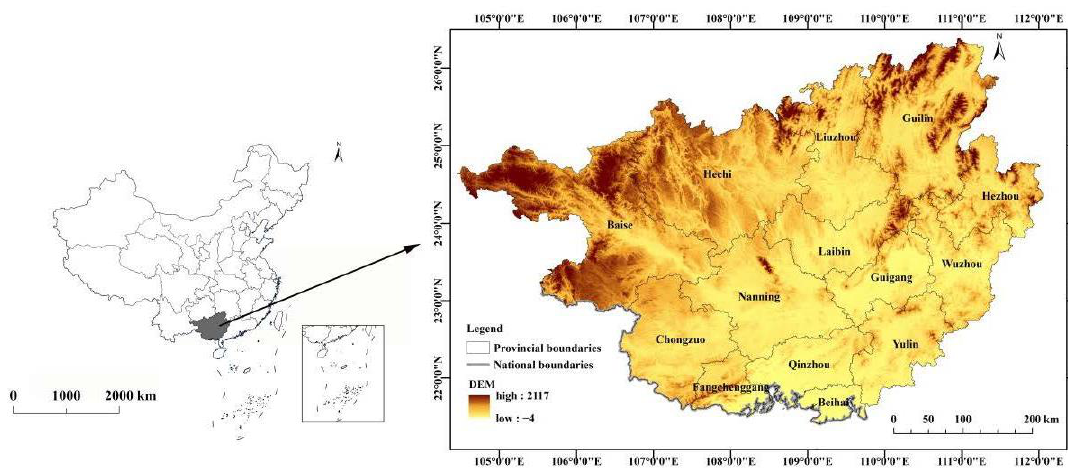
Figure 2. Location of Guangxi, the study area in southern China.